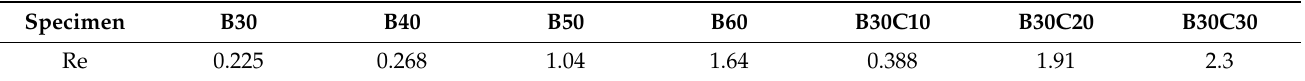
Table 7. Relative permeability coefficient of different plastic concrete specimens ( × 10 − 8